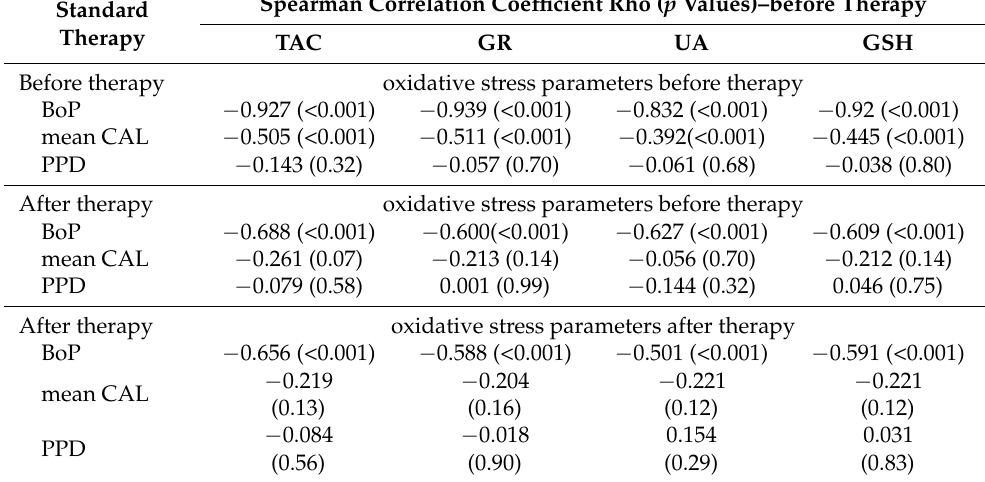
Table 4. Correlation between oxidative stress parameters and periodontal indices in patients with “standard” therapy.